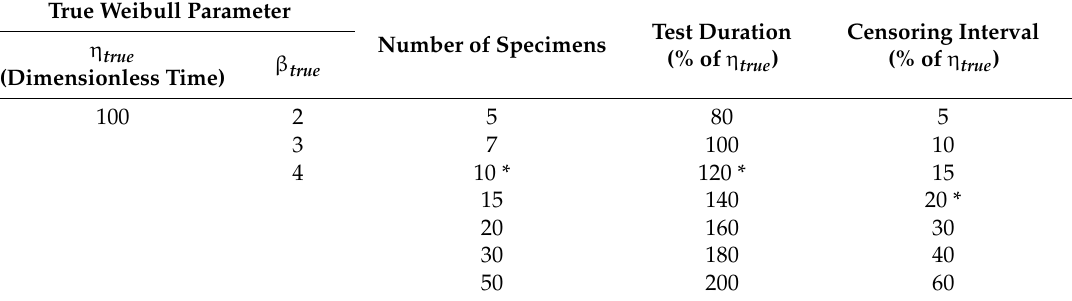
Table 2. Experimental conditions for the Monte Carlo simulation.